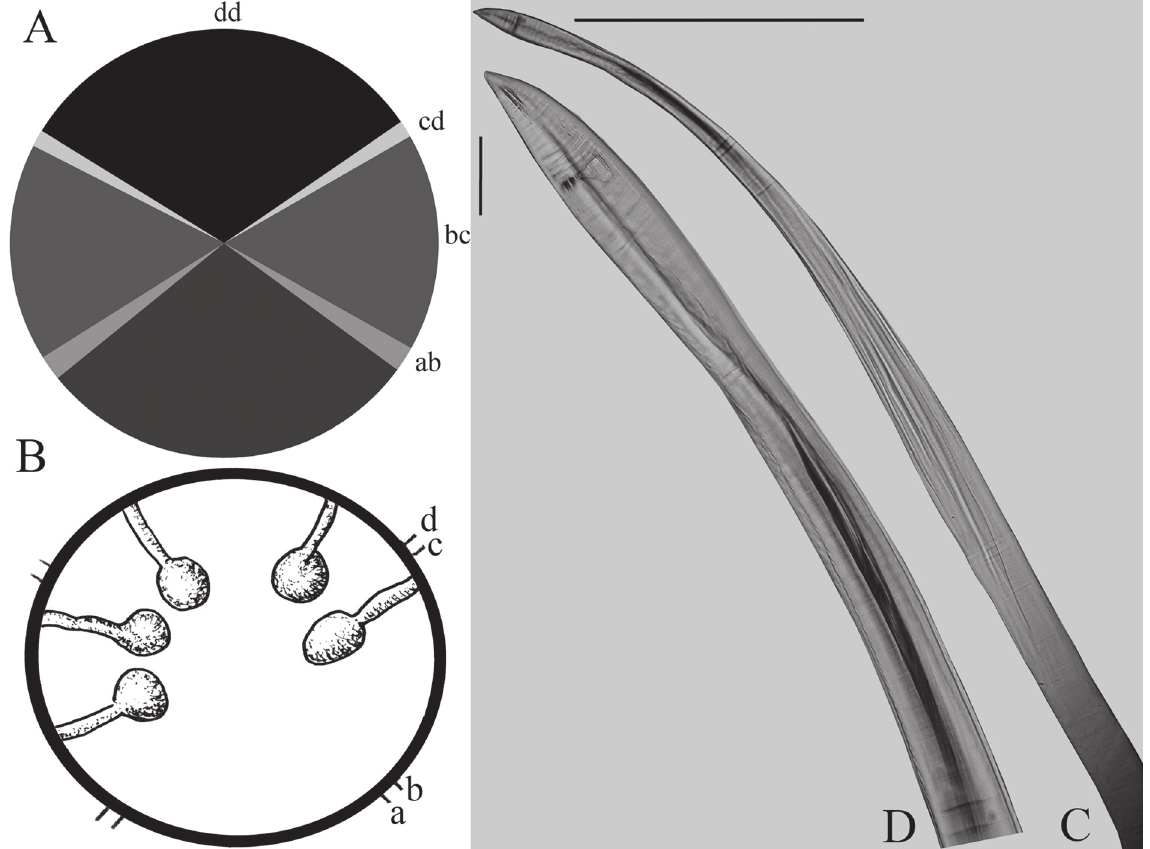
Fig. 4. Kynotus voimmanus sp. nov. A . Setal arrangement, a, b, c, d representing setal lines. B . Spermathecae (13/14) schematic representation. C . Genital seta. D . Tip of the genital seta. Scale bars: C = 0.6 mm; D = 0.1